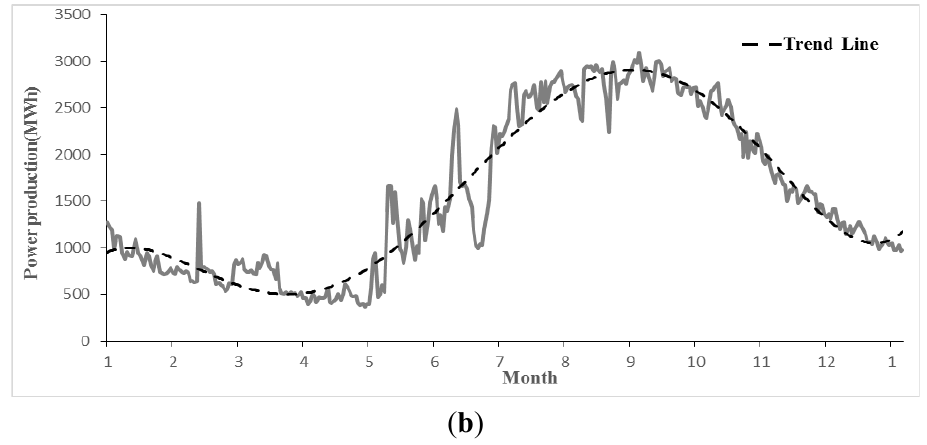
Figure 3. Power production curve and its tread line of SHP plant ( a ) Monthly power production and trend line of single SHP plant; ( b ) Monthly power production and trend line of SHP plants in